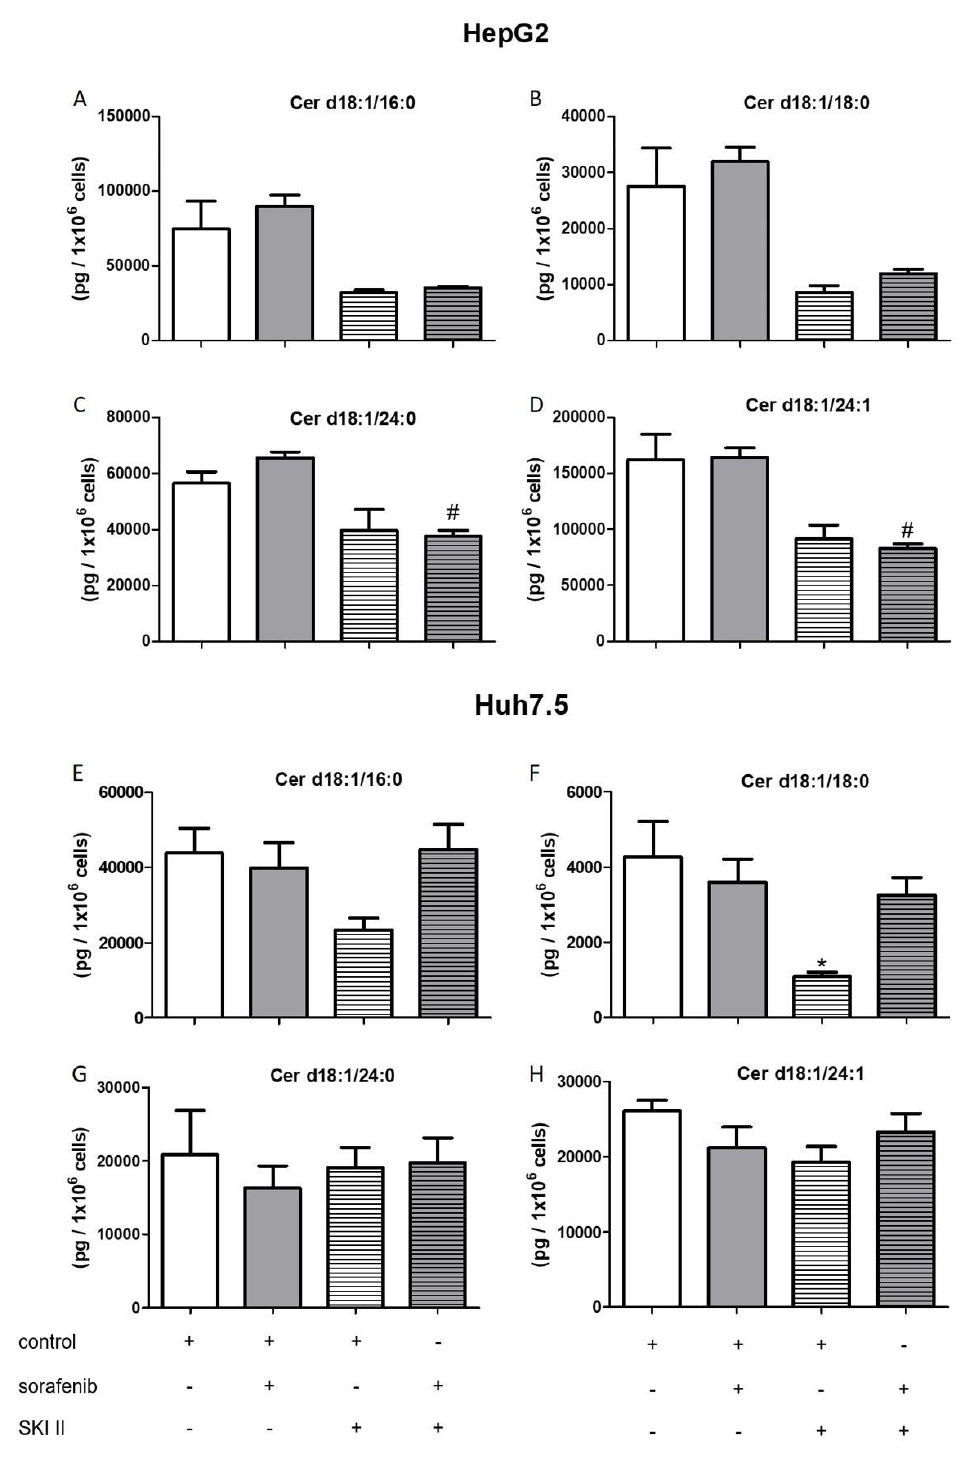
Figure 8. Influence of sorafenib and SKI II on concentrations of d18:1 ceramides in HepG2 and Huh7.5 cells. The lipids were measured by LC-MS / MS. The cells (HepG2 in ( A )–( D ) and Huh7.5 in ( E )–( H )) were treated with or without 25 µ M FB1 for 1 h before the addition of vehicle (control; 0.2% DMSO) or 5 µ M sorafenib and further incubation for 24 h. All results are presented as means ± SEM of 3–6 independent experiments. * p < 0.05 compared to control; # p < 0.05 compared to sorafenib in one-way ANOVA followed by Bonferroni